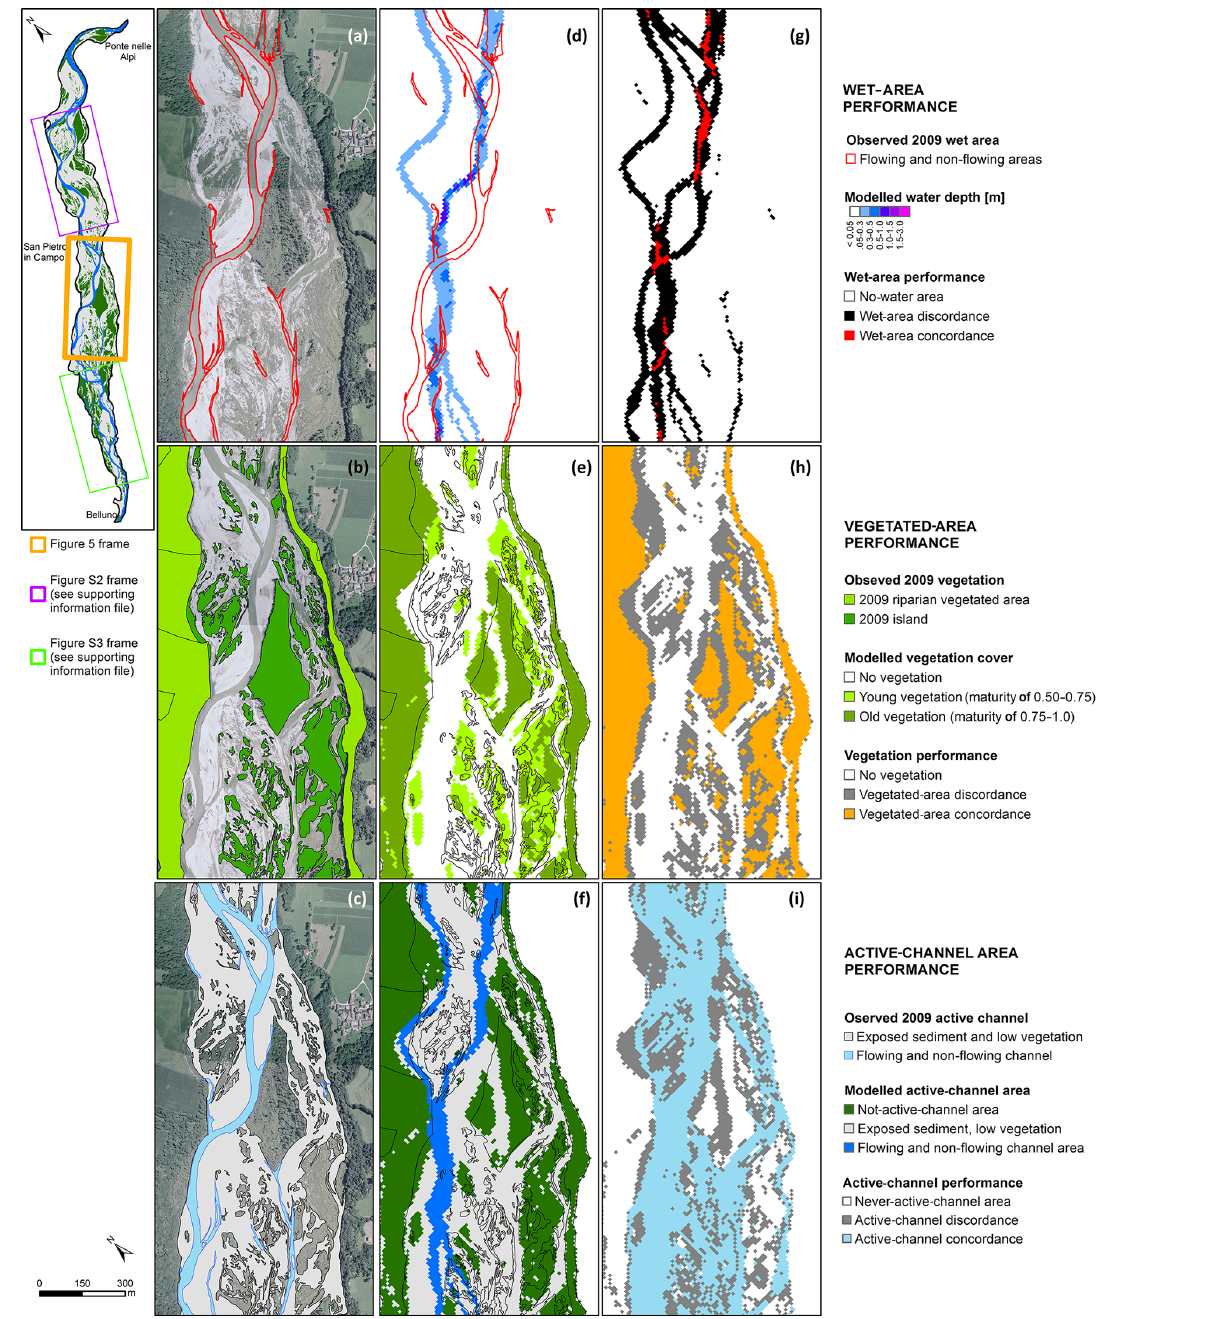
Figure 5. Model performance assessment at the end of the calibration runs (mid frame; see the Supplement for the others frames): (a) wet area, (b) vegetated area and (c) active channel digitalized using 5 August 2009 aerial photos; (d) overlay between modelled and observed flowing channel; (e) overlay between modelled and vegetated area; (f) overlay between modelled and observed active channel; (g) wet-area performance index calculation; (h) vegetated-area performance index calculation; and (i) active-channel performance index